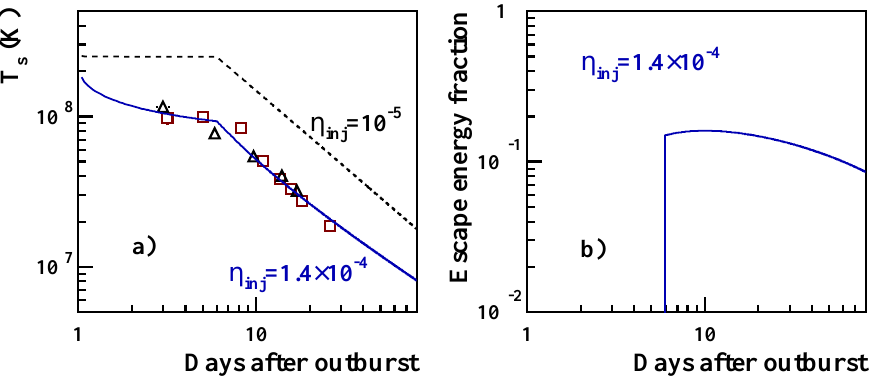
Fig. 2. (a) Calculated postshock temperature for two values of (cid:17) inj compared to the RXTE and Swift data (same symbols as in Figure 1). (b) Cosmic-ray escape energy fraction, starting on day 6, for the best-fit acceleration efficiency (cid:17) inj . moderate acceleration efficiency (cid:17) inj (cid:24) 10 − 4 (Tatischeff & Hernanz 2007),